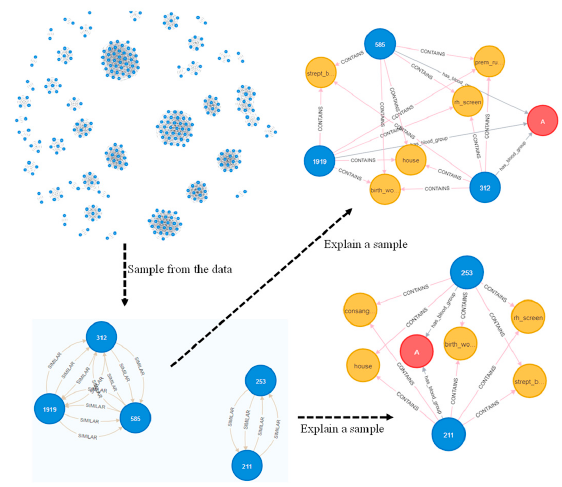
Figure 6. Node similarity algorithm showing the reason why patients may be similar to each other i.e., due to the complications they share. Yellow nodes represent the disease, blue nodes represent the node patients, and red is the blood group.